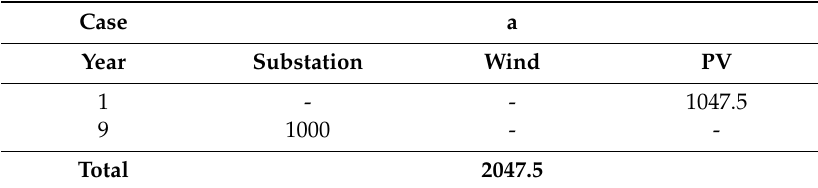
Table 5. Power installed (kW) in Case